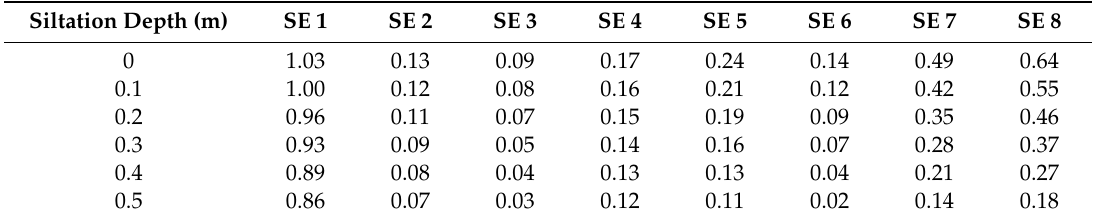
Table 7. E-flow requirements (m 3 / s) for di ff erent river segments (SE) under the low hydrological connectivity scenario.